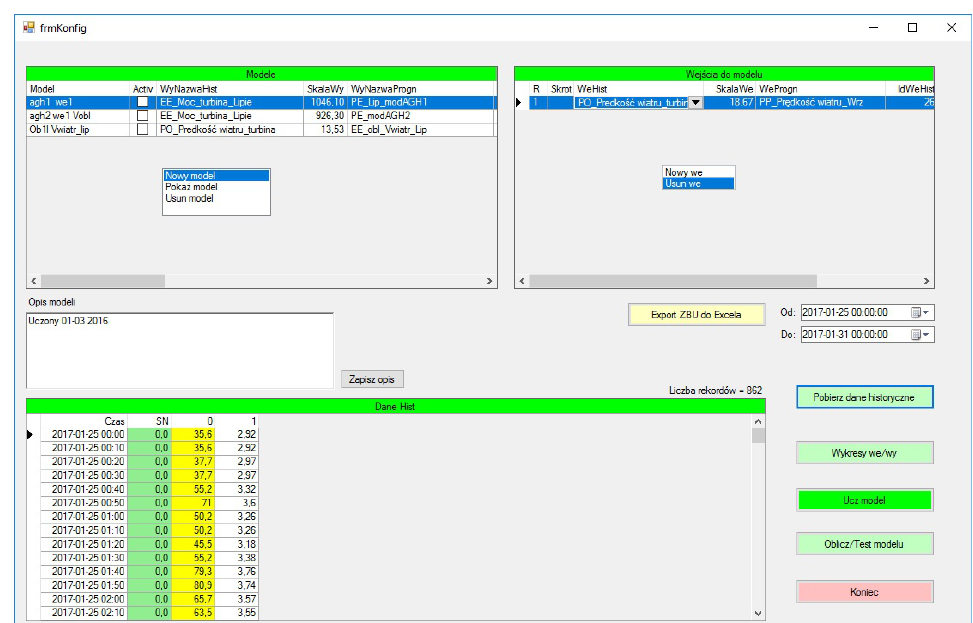
Figure A1. Main window of the model preparation